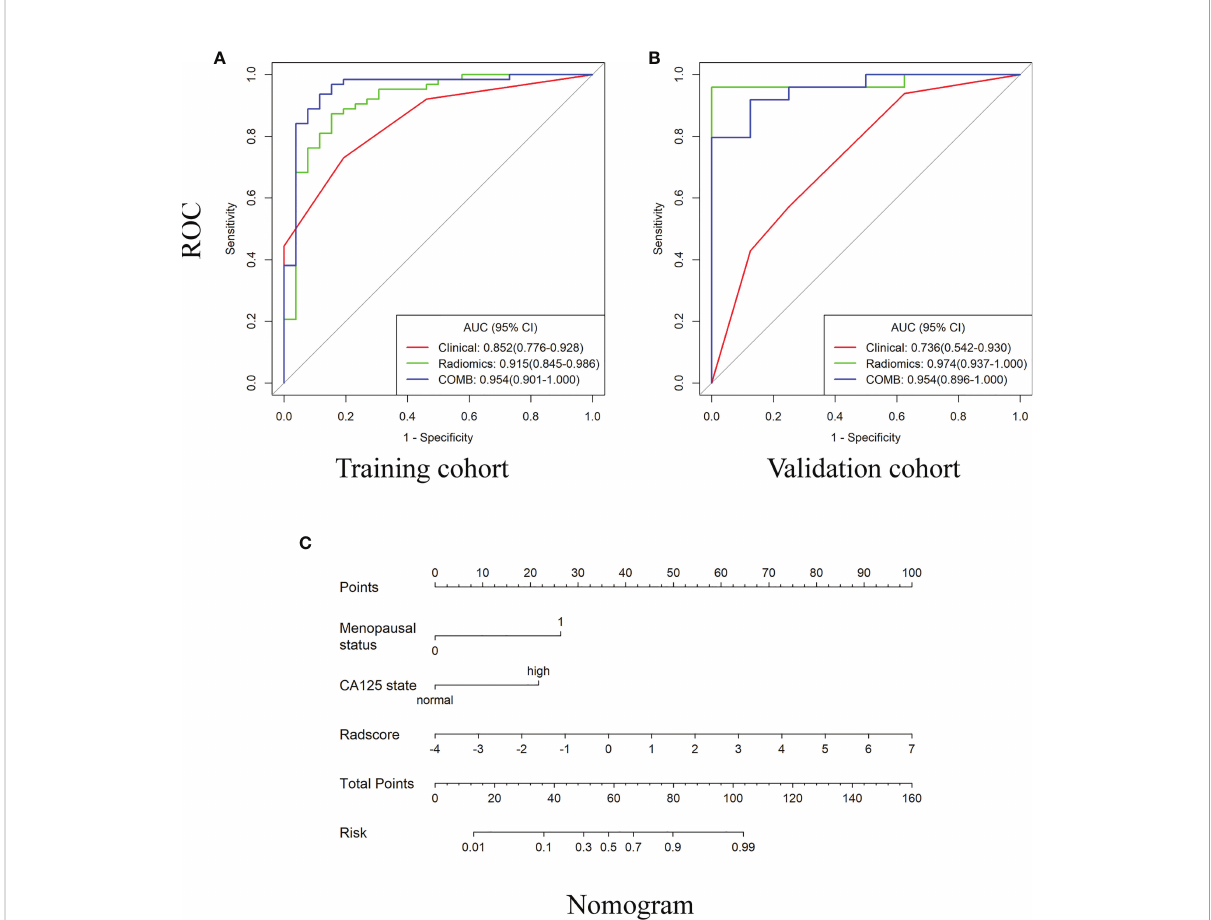
FIGURE 3 The receiver operating characteristic (ROC) curves and the nomogram for preoperatively distinguishing borderline epithelial ovarian tumor from epithelial ovarian cancer. (A – B) The ROC curves of clinical, radiomics and nomogram in training and validations cohorts. (C) The DWI-based radiomics nomogram.